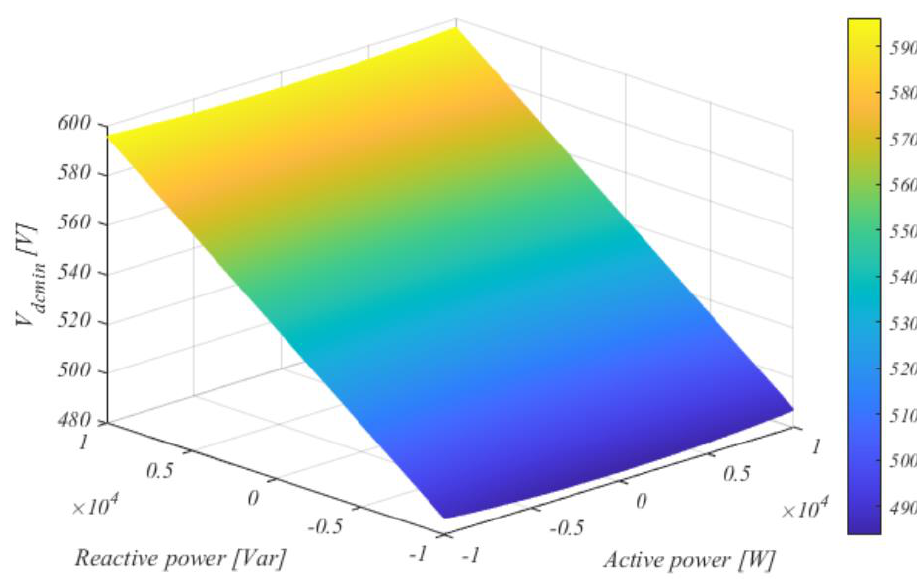
Figure 8. Minimum DC link voltage ( V dcmin ) based on active and reactive powers.